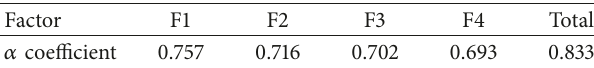
Table 8: 𝛼 coefficients of factors. Table 9: Correlations between criteria and